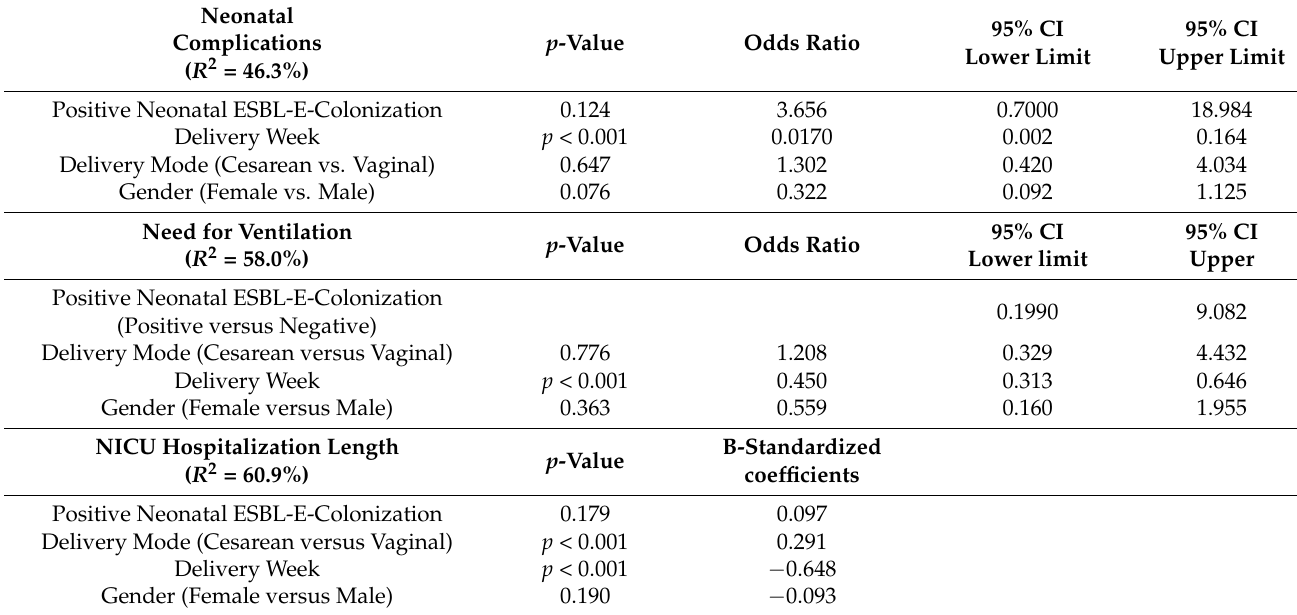
Table 6. Multivariate regression: correlation between variables and neonatal outcome in NICU.